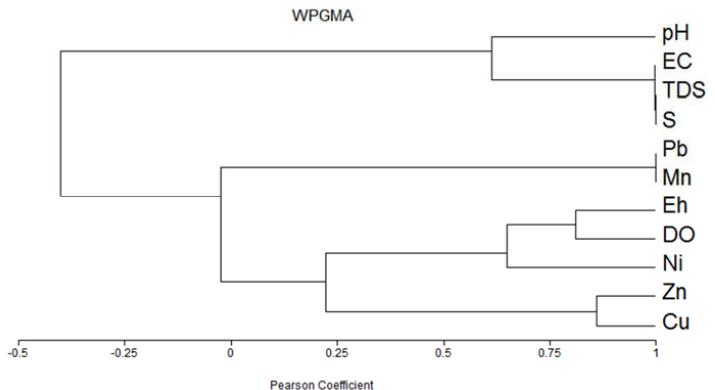
Fig. 4: Reduction trend of concentration of Pb and Mn (a), Zn (b), Cu and Ni (c) due to flocculation process in Sardabroud’s estuary Fig. 5: Dendrogram of cluster analysis with MVSP Fig. 5: Dendrogram of cluster analysis with MVSP software